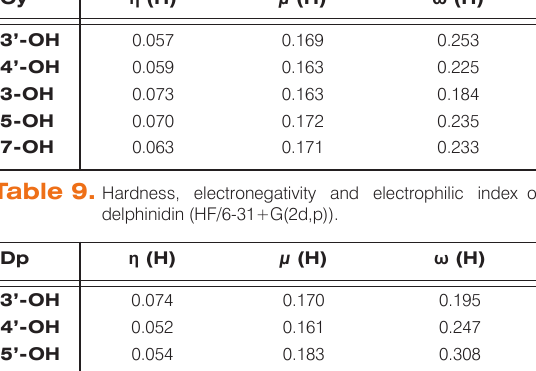
Table 8. Hardness, electronegativity and electrophilic index of cyanidin (ROHF/6-31+G(2d,p)). Cy η (H) μ (H) ω (H)